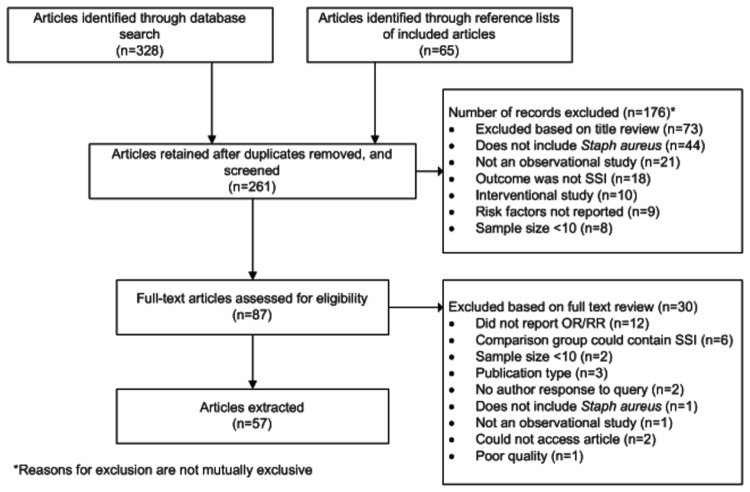
Flow diagram depicting articles excluded from the review, including stage of, and reason for, exclusion in systematic review of risk factors for surgical site infection.